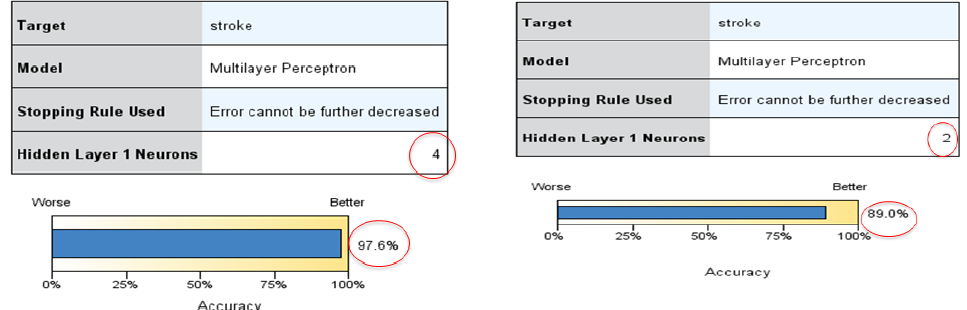
Figure 1. The best Neural Network models with data sizes 2907 and 550.